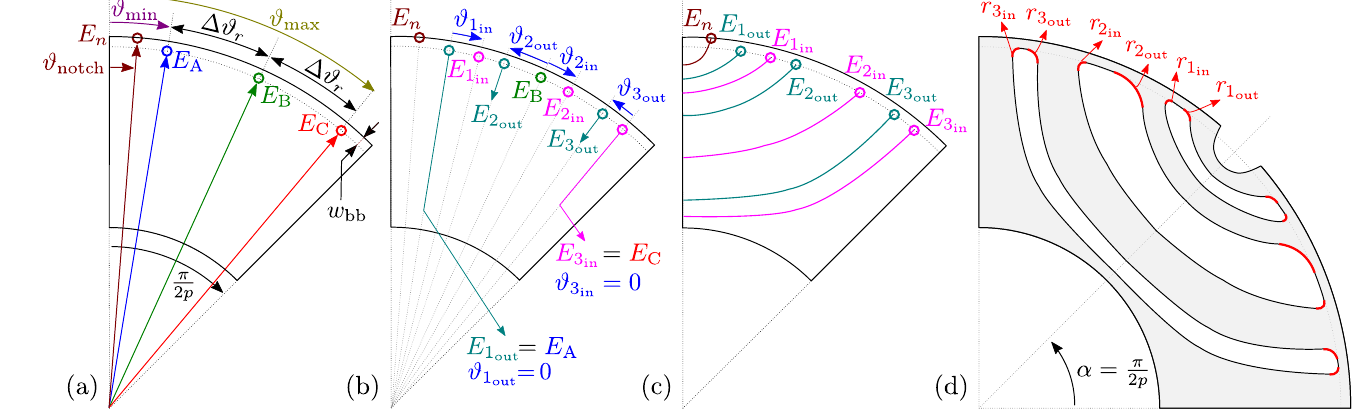
Figure 4. Rotor barrier construction procedure for a three barrier rotor, k =